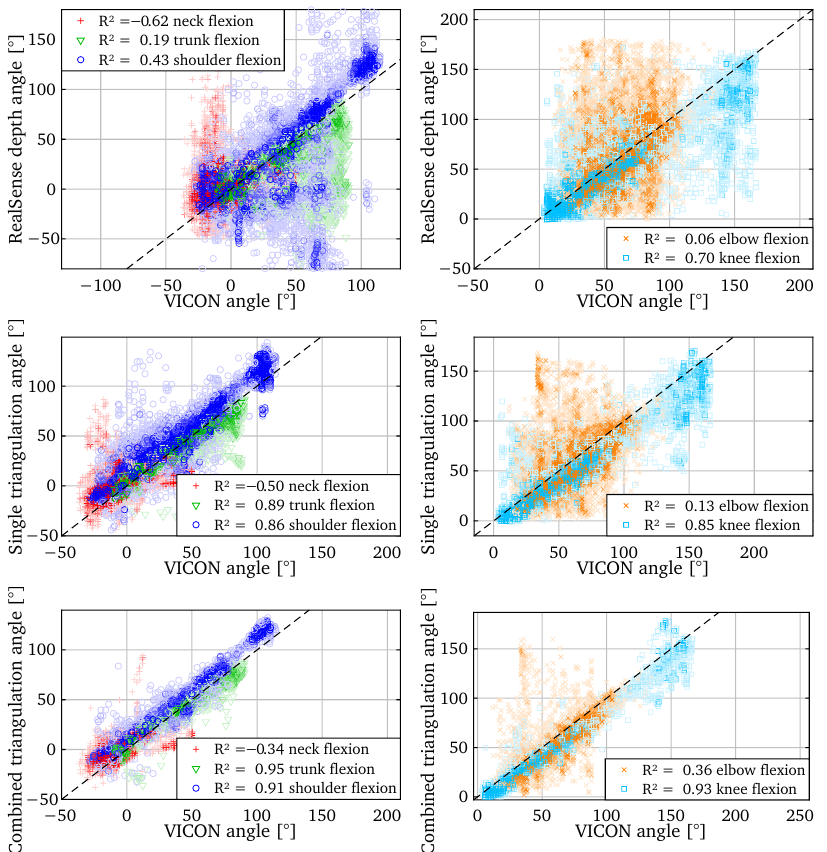
Figure 8. A selection of five joint angles compared to angles from the VICON data. From top to bottom : calculated from RealSense depth, single triangulation and combined triangulation.